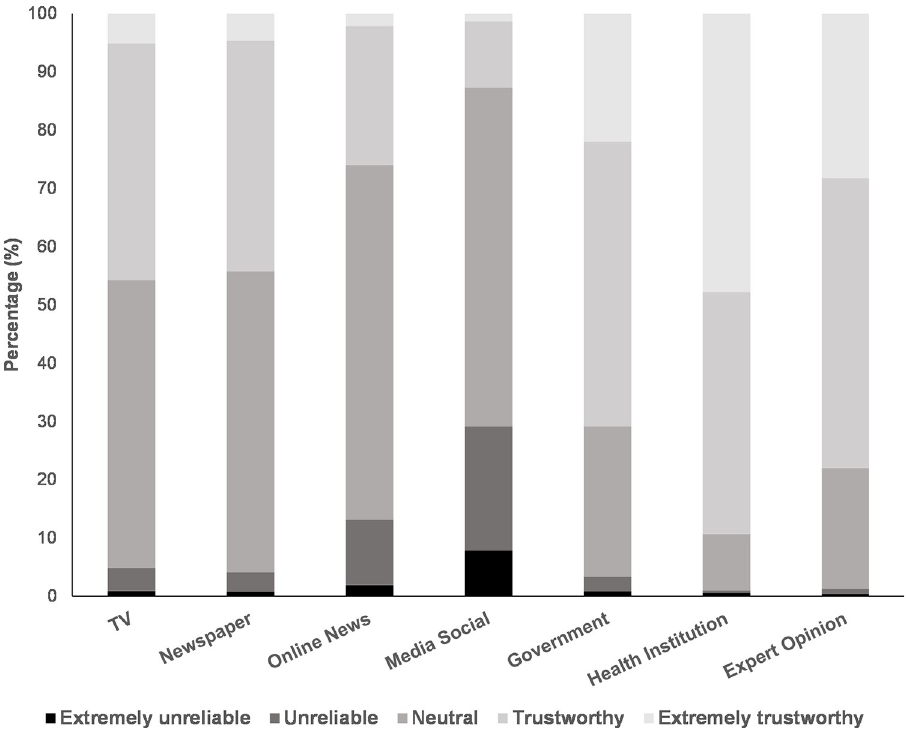
Fig 2. Levels of trust of the study population toward COVID-19 health information released by various media outlet.